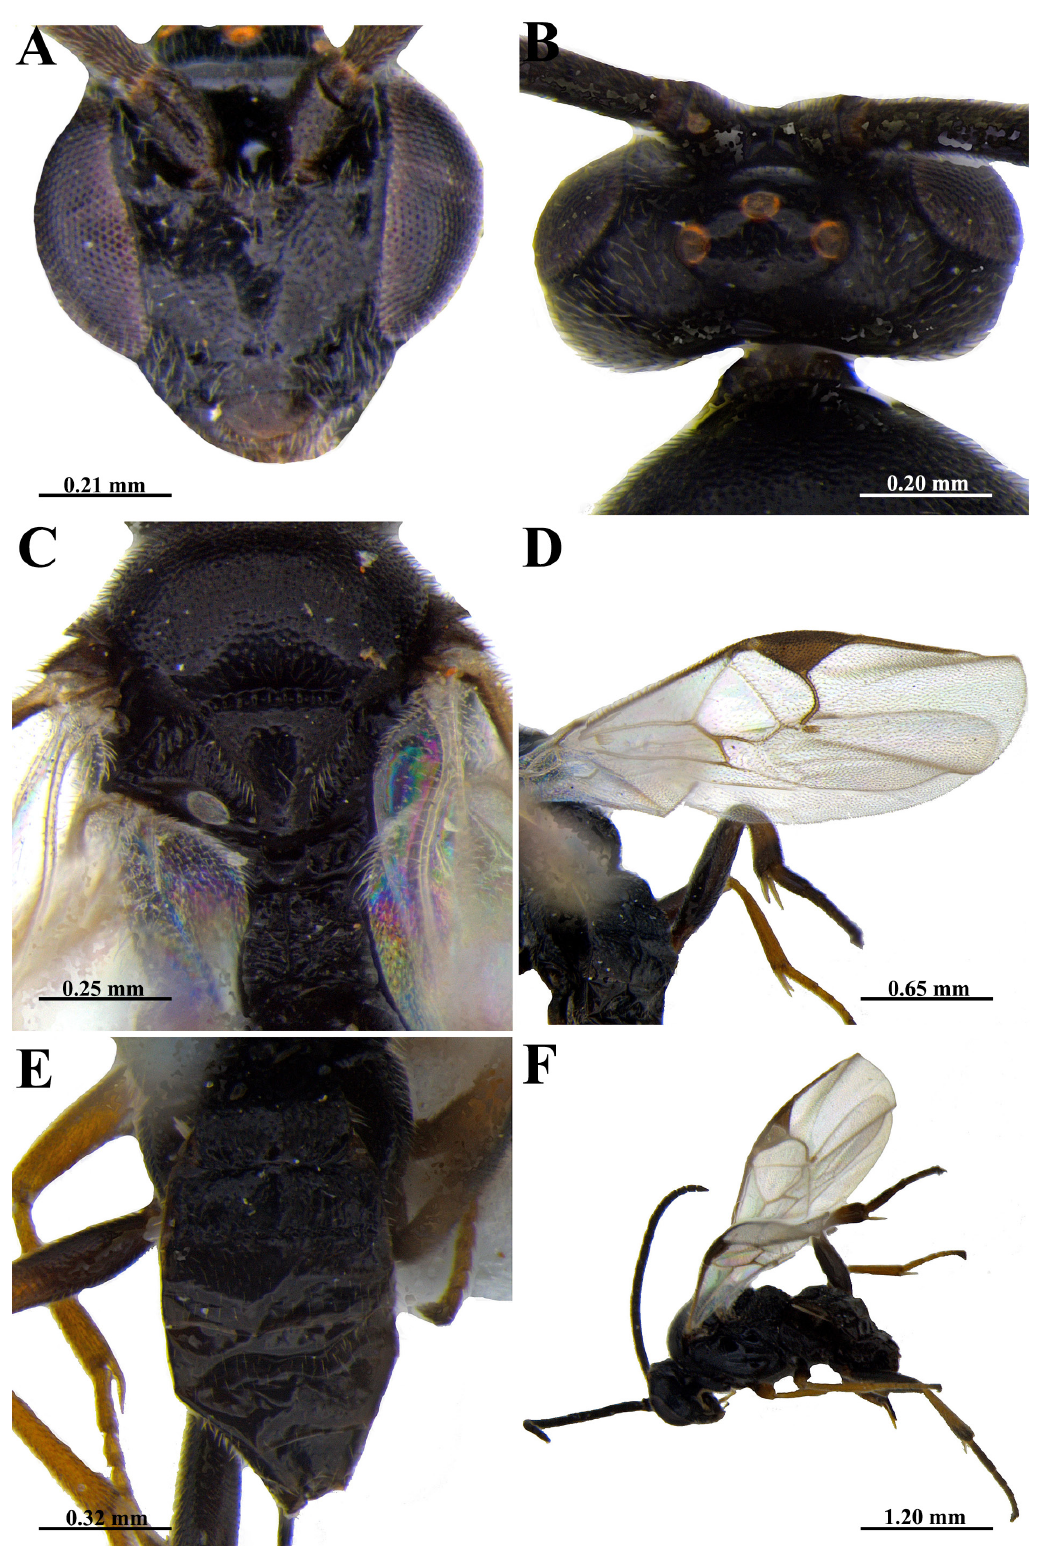
Fig. 5. Cotesia glabrata (Telenga, 1955), ICAR-NBAIR/NIM/MICROG/COT/20416. A . Head, frontal view. B . Head, dorsal view. C . Mesosoma, dorsal view. D . Fore wing. E . Metasoma, dorsal view. F . Habitus, lateral